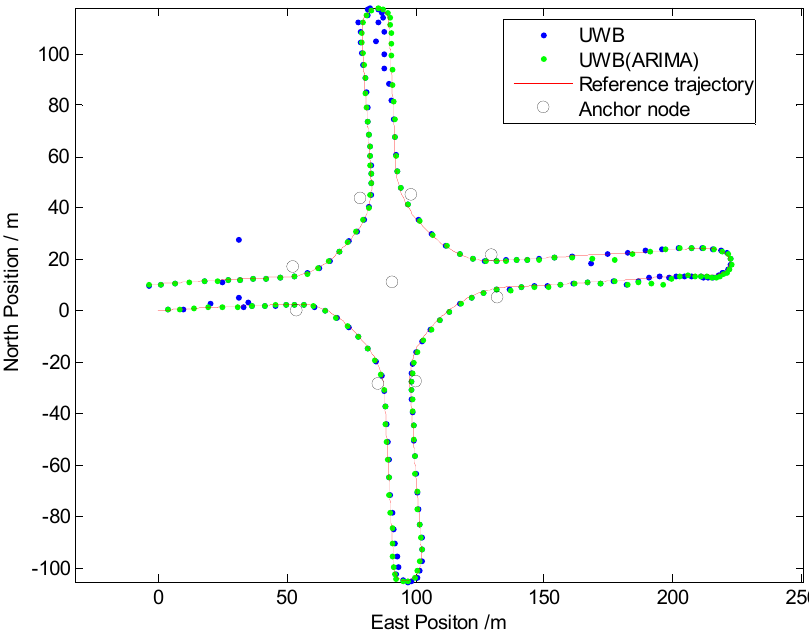
Figure 9. Positioning results in Trajectory III.